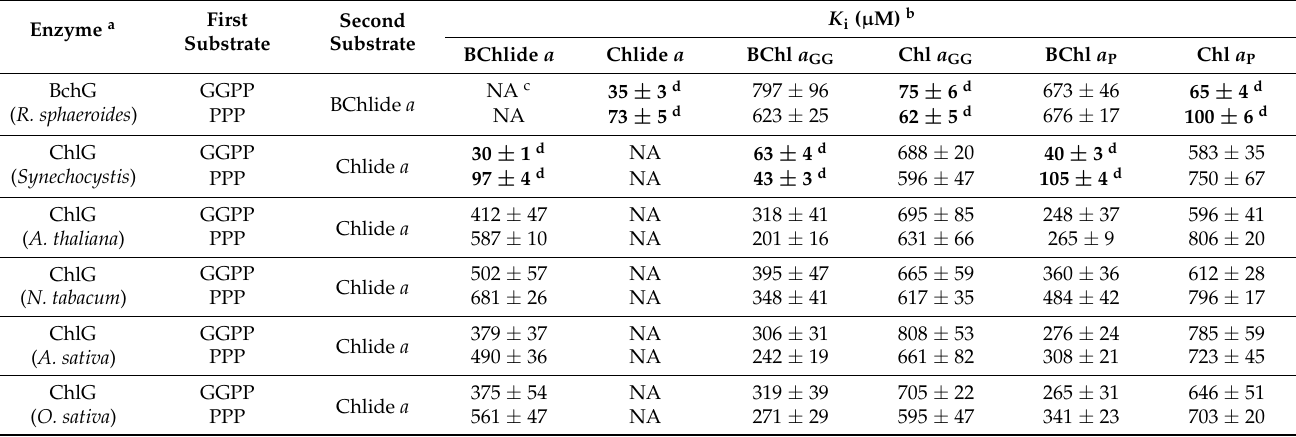
Table 3. Inhibition constants of BchG and ChlGs for bacteriochlorin and